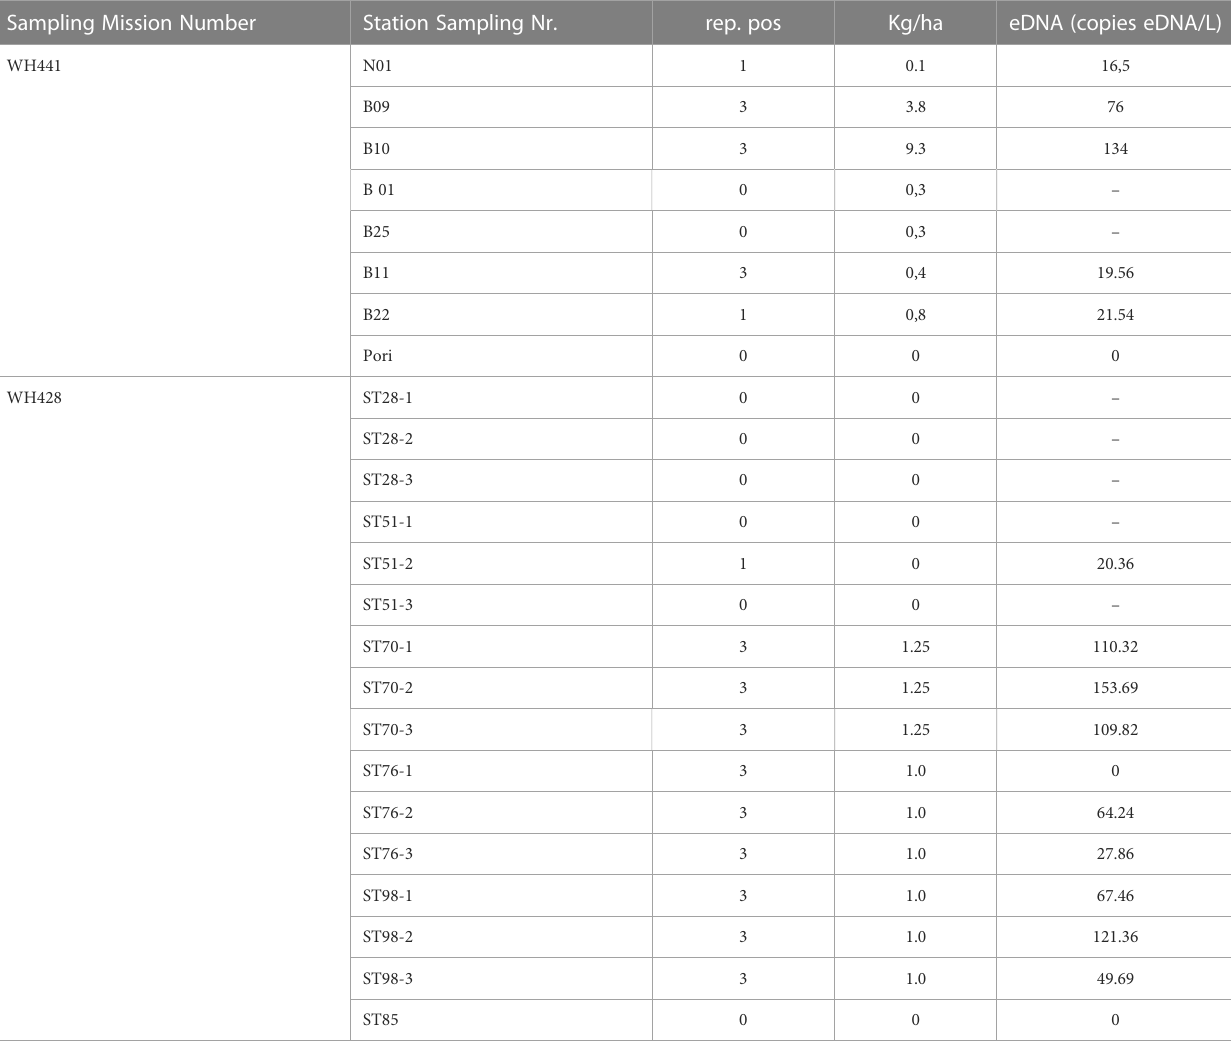
TABLE 4 The average measured eDNA (copies/L of seawater) in seawater samples from 17 stations is presented together with catches (kg), eDNA levels (copies/L of fi ltered water), and catches per unit effort (unit/ha). Sampling Mission Number Station Sampling